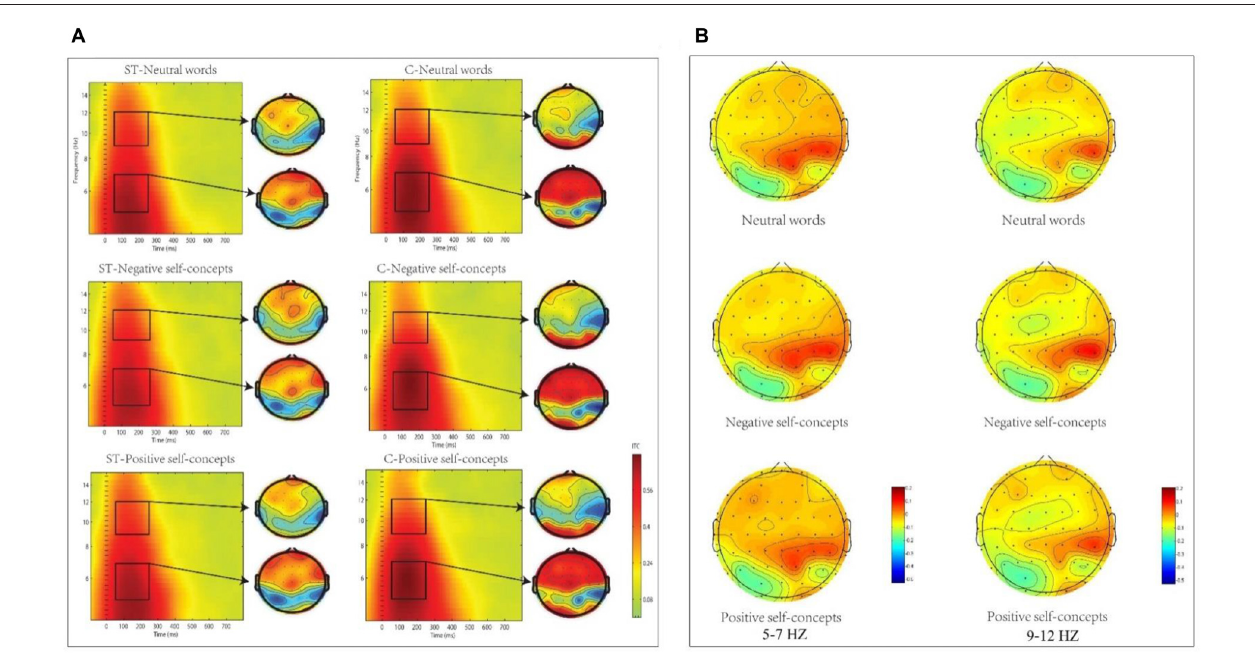
FIGURE 3 | (A) The inter-trial coherence (ITC) elicited by neutral words, positive self-concepts and negative self-concepts at Cz in aging ST and control groups (C) were presented by square chart. Red represented enhanced ITC and blue represented reduced ITC. The topographical maps on the right side of the square chart illustrate the ITC distribution for 5–7 Hz and 9–12 Hz at 50–250 ms for each condition. (B) Topographic maps of condition differences for 5–7 Hz (left) and 9–12 Hz at 50–250 ms